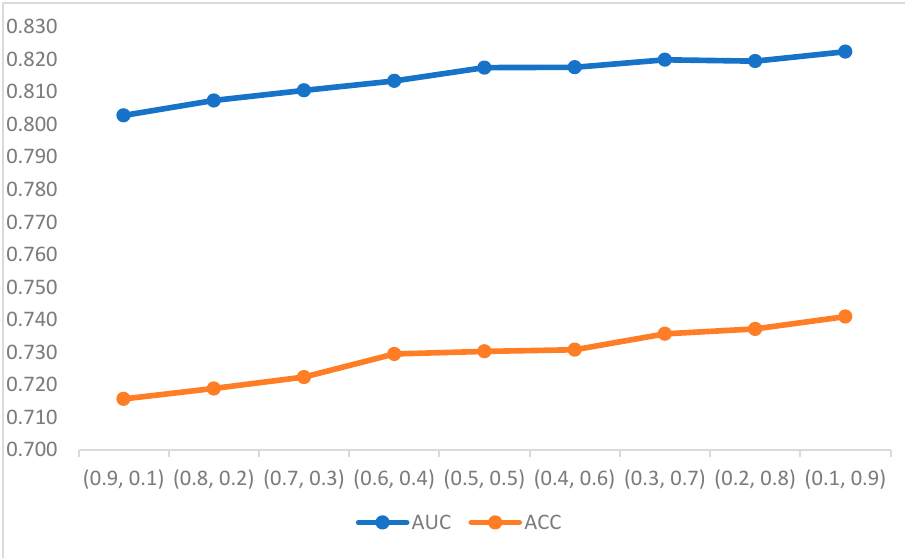
0.7000.7100.7200.7300.7400.7500.7600.7700.7800.7900.8000.8100.8200.830 Figure 4. Impact of di ff erent hyperparameters on the performance of KGG model on Last.FM. Figure 4. Impact of different hyperparameters on the performance of KGG model on Last.FM. 0.8300.8380.8460.8540.8620.8700.8780.8860.8940.9020.9100.9180.926 Figure 5. Impact of di ff erent hyperparameters on the performance of KGG model on Movielens-1M. Figure 5. Impact of different hyperparameters on the performance of KGG model on Figure 6. Impact of di ff erent hyperparameters on the performance of KGG model on Book-Crossing. 4.4.3. Analysis of Model Validity (RQ3) To explore whether the local interest feature module and global interest feature mod- ule in the KGG model have an e ff ect on the fi nal performance, we removed the global interest feature module and only used the local interest feature module for training. The results are shown in Figure 7, where the orange bar chart represents the local interest fea- ture module (KGCN model), and the blue bar chart represents the KGG model. In order to make a fair comparison, all training parameters were kept identical under the same conditions.